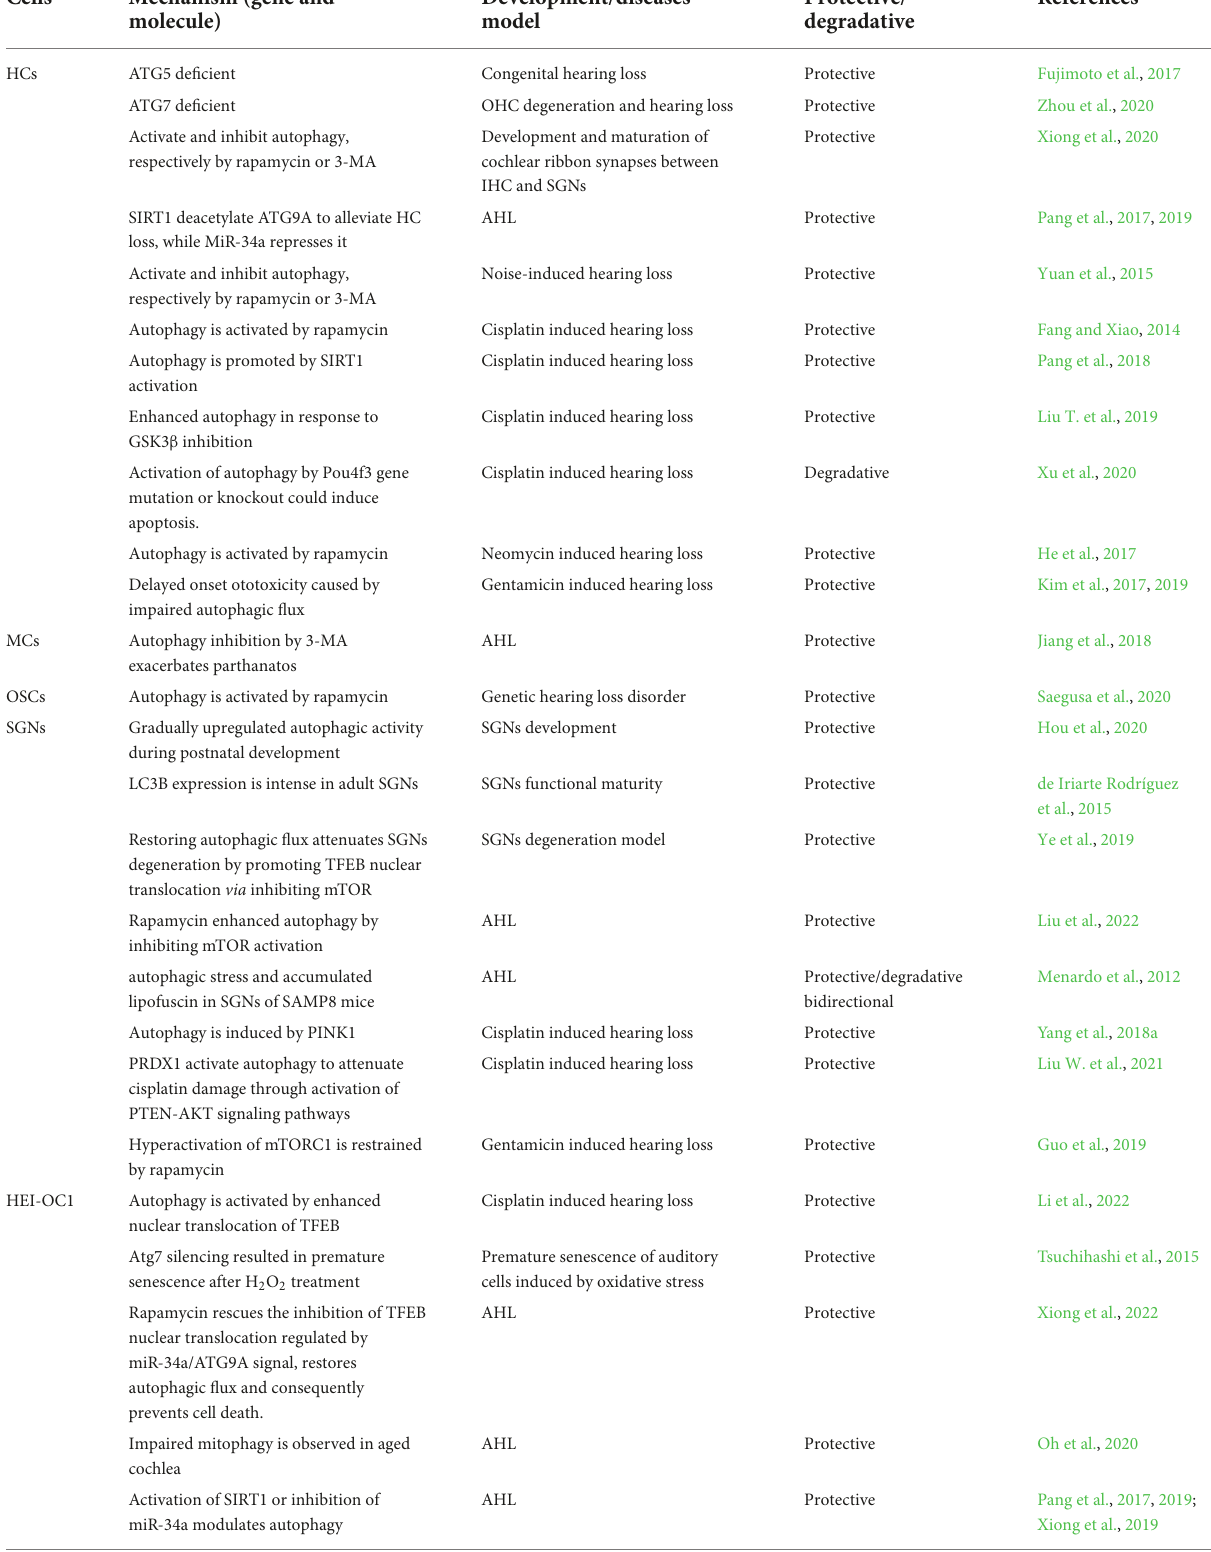
TABLE 1 Researches on the mechanism and function of autophagy in various cells of auditory